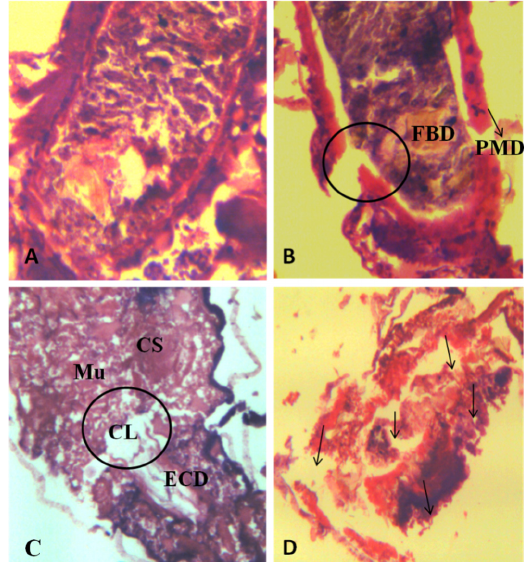
Figure 6. Longitudinal sections in the posterior region of the midgut of an A. aegypti 4th instar larvae, magnification: 10 × . ( A ) control; ( B ) a larva under treatment with 10 ppm selenium nanoparticles; ( C ) a larva under treatment with 50 ppm selenium nanoparticles; ( D ) a larva under treatment with 100 ppm selenium nanoparticles. The arrow indicates the disordered and broken epithelial cell layer, complete breakup of mid-gut and caeca and collapsed larval structure, respectively. Mu: muscles; FB: food bolus; CL: cell lysis; PMD: peritrophic membrane damage; FBD: food bolus damage; ECD: epithelial cells damage; CS: separated